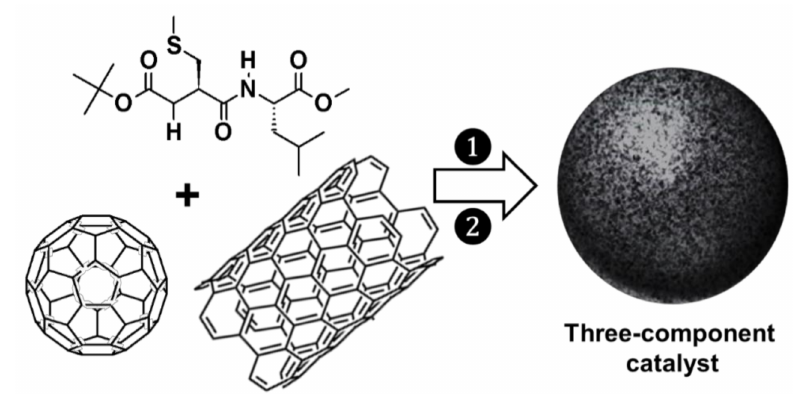
Figure 47. The self-assembly of a terminally protected hydrophobic dipeptide (Boc-L-Cys(Me)-L- Leu-OMe) with carbon-based materials (carbon nanotubes and fullerene C 60 to obtain a ternary catalyst (1: formation of organogel, and 2: vacuum